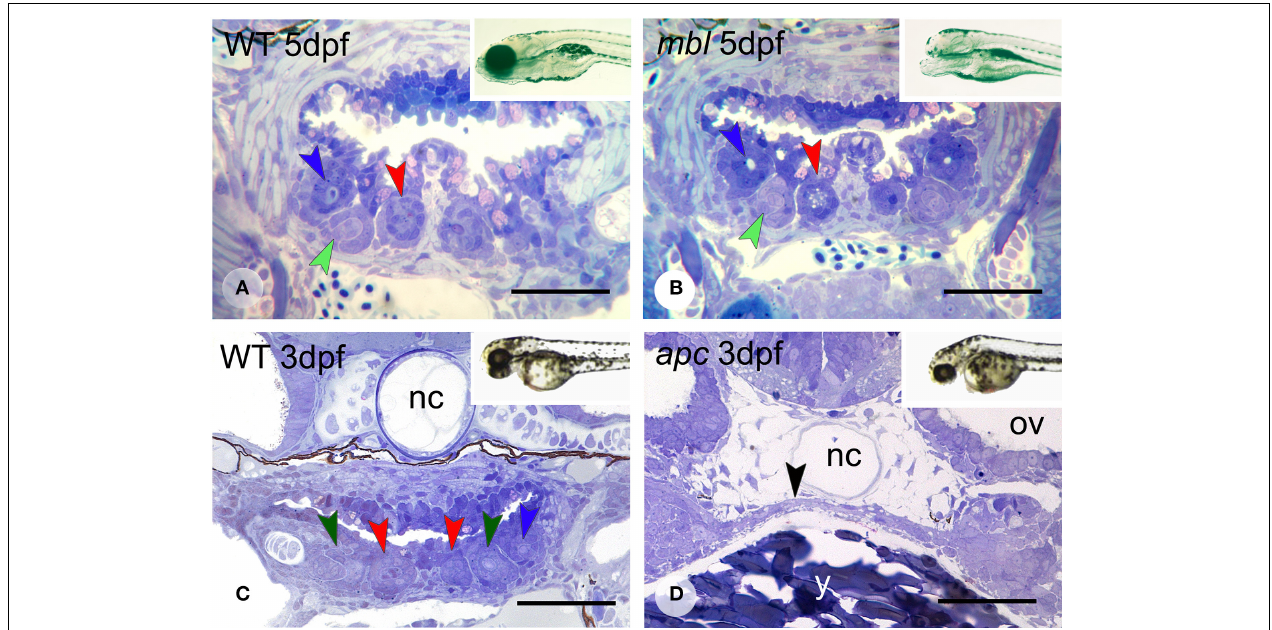
FIGURE 4 | Dentition in mbl and apc mutant zebrafish. Dentition in WT (A) and mbl mutants (B) at 5dpf, and WT (C) and apc mutants (D) at 3dpf. Insets: WT (A) and mbl mutant (B) at 6dpf, and WT (C) and apc mutant (D) at 2dpf. Color codes for arrowheads as in Figure 3 . Note the complete similarity in tooth pattern between 5dpf WT (A) and mbl mutants (B) , and the substantial developmental delay in 3dpf apc